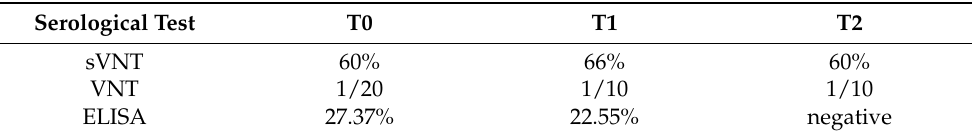
Table 2. Serological findings recorded at arrival (T0) and at first (T1) and second control (T2) in the dog from this